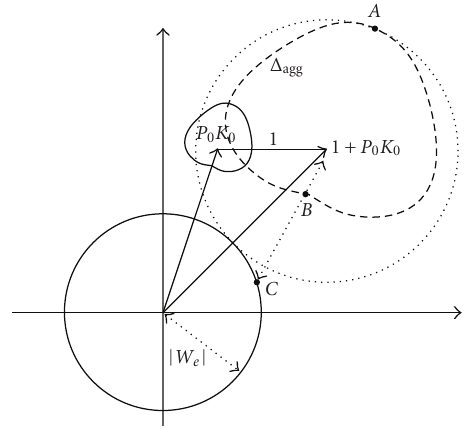
Figure 3: Nominal system characteristics, arbitrary aggregated uncertainty set and the su ffi cient upper